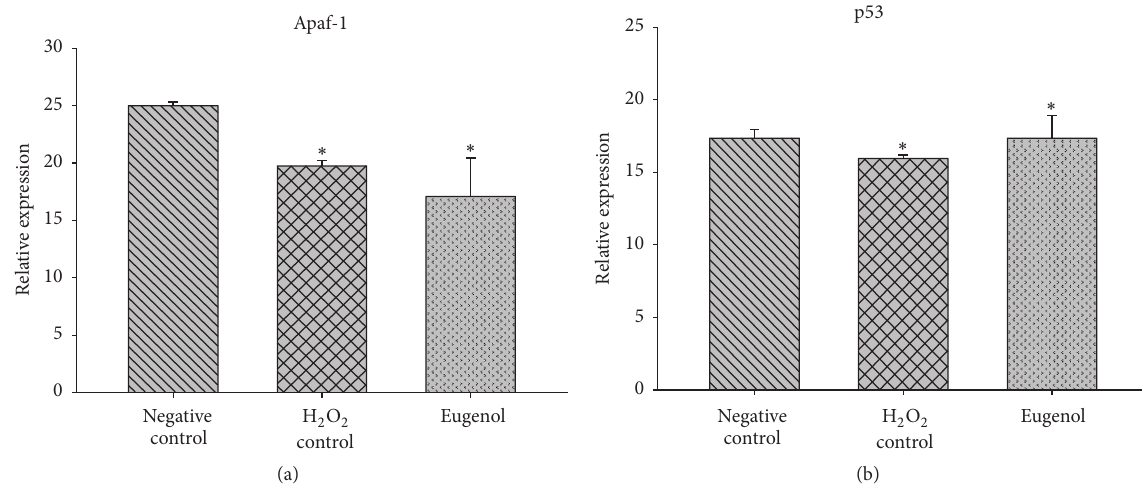
Figure 2: Relative expression of genes involved in the apoptotic process. Apaf-1-apoptotic peptidase activation factor 1; p53-tumor suppressor p53. ∗ The differences in the mean values among the treatment groups with respect to negative control are greater than what would be expected by chance; there is a statistically significant difference ( 𝑝 < 0.05